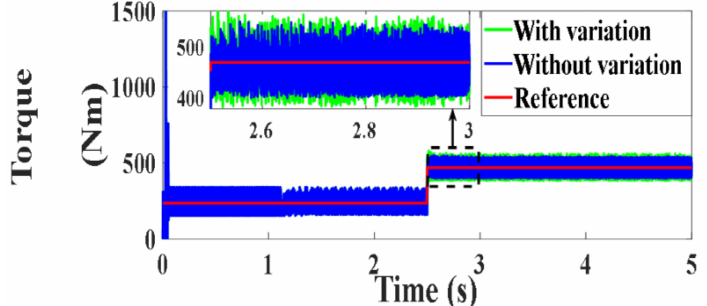
Figure 111. Developed torque under PVC (Nm).